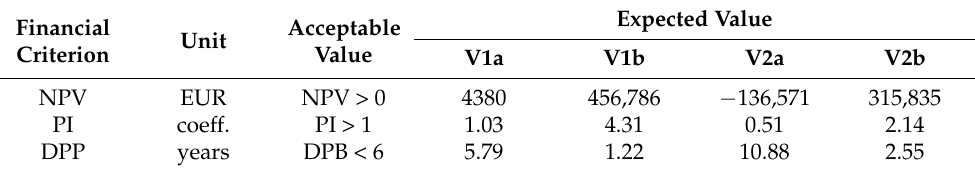
Table 6. Financial criteria of economic efficiency—deterministic approach.